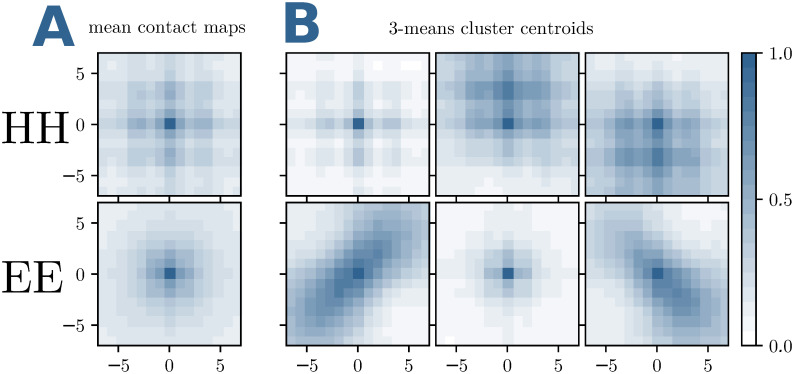
Typical patterns in inter-domain contact matrices.(A) The frequencies of contacts in a 15×15 contact-map window around an HH or EE contact are displayed. The average is done over the 46978 HH and 12281 EE contacts of the training set. The mean contact matrices are a combination of parallel, anti-parallel or mixed HH and EE contacts. (B) We disentangle them with a k-means clustering with k = 3. The 6 resulting centroids, 3 for a central HH inter-domain contact (upper row) and 3 for an EE contact (lower row), show pronounced patterns and can be used to filter DCA predictions.